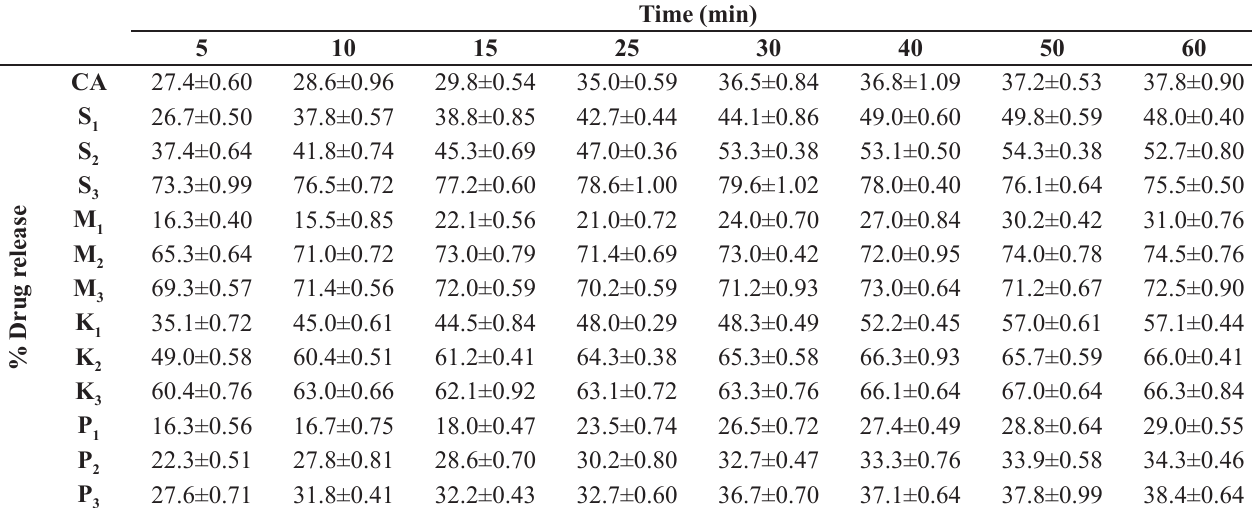
TABLE II - Drug release pattern of various